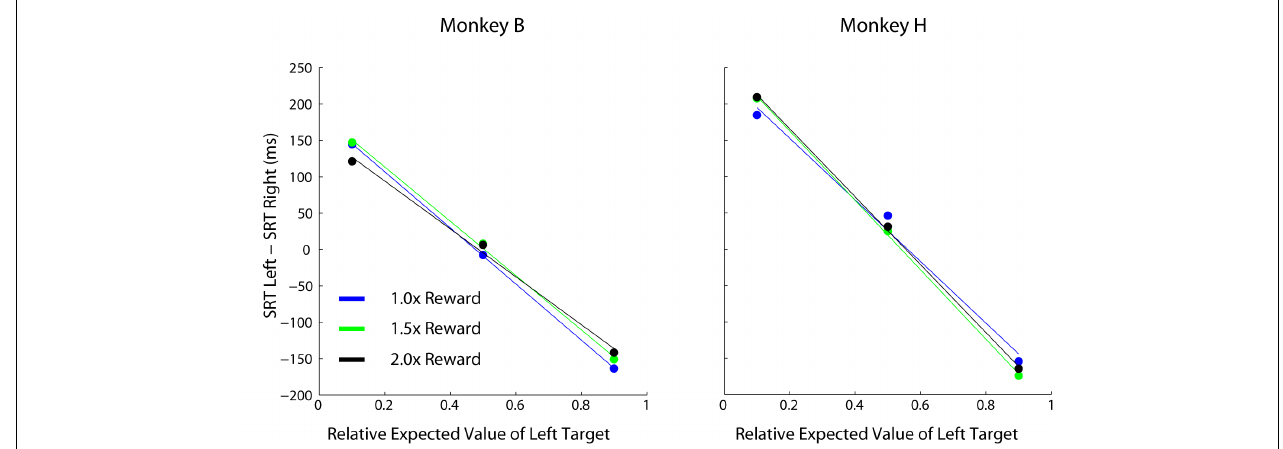
had the same relative expected values (indicated by the bold cells in Table 1 ), however, all reward magnitudes were increased by the stated multiples between conditions (i.e., different absolute expected value at each